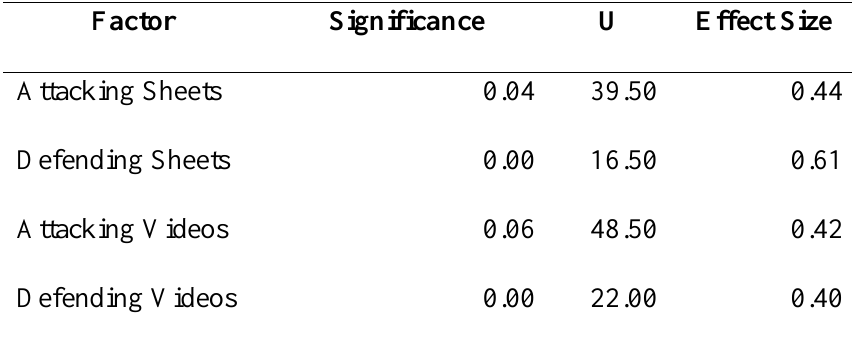
Table 3.5 shows the comparisons between actual and random defenders. A Mann- Whitney U test was used to compare actual dyads with random defenders. The results show three significant values in comparisons linked to Attacking and Defending